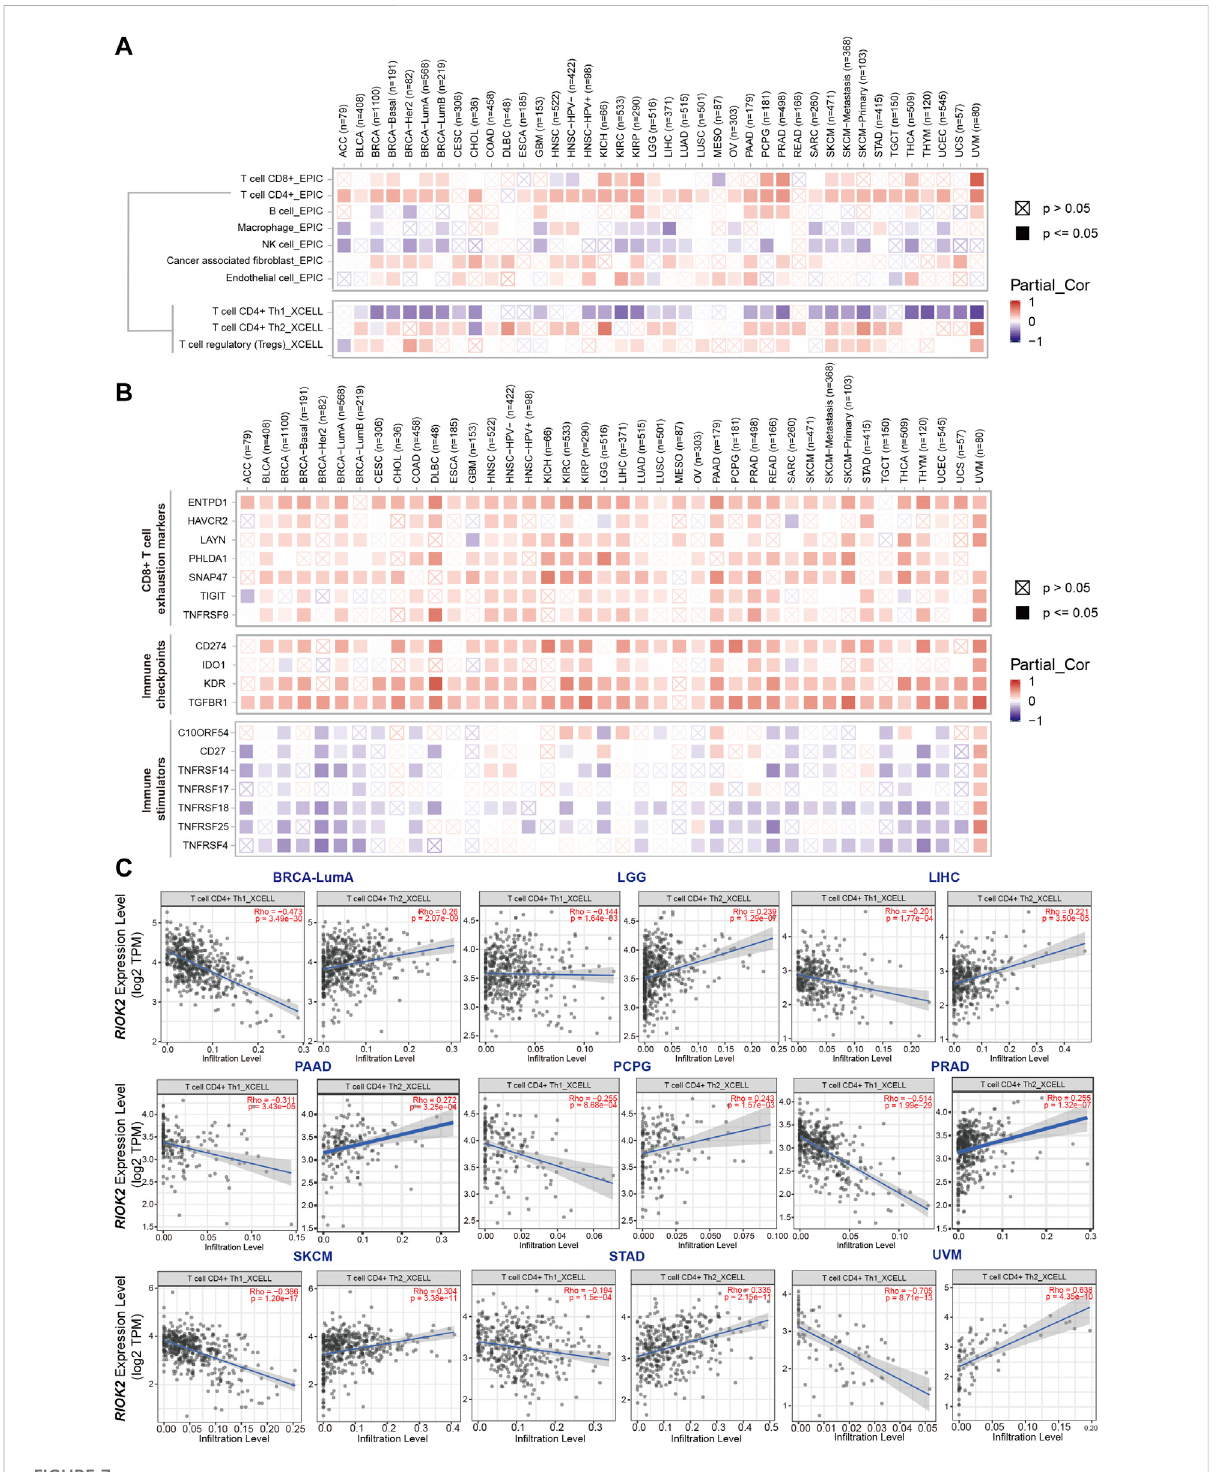
The expressionof RIOK2 iscorrelated with immunecells in fi ltration and biomarkers incancer. (A) A heat map showing thecorrelation between RIOK2 expression and immune in fi ltration levels in diverse cancer types. The correlation of in fi ltrating cells were obtained using the EPIC algorithm, and the correlation of CD4+T cell subtypes by using the xCell algorithm with Spearman purity adjustment. (B) A heat map conveys the correlation between RIOK2 expression and seven CD8+T exhaustion markers, four immune checkpoints, and seven immune stimulators in diverse cancer types. (C) ScatterplotsshowingtherelationshipbetweenCD4+Th1andCD4+Th2in fi ltratevaluesandRIOK2expression.Spearman ’ scorrelationwas employed to conduct a purity adjustment